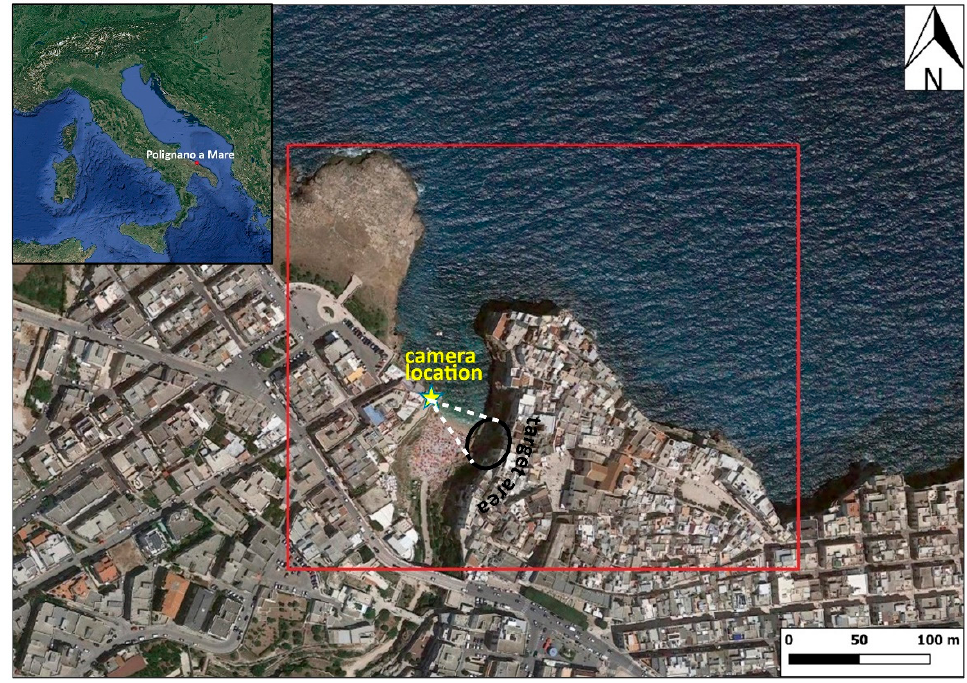
Figure 2. Location of the study area (base map retrieved from Google Satellite). The thermal imager is represented by the yellow marker.